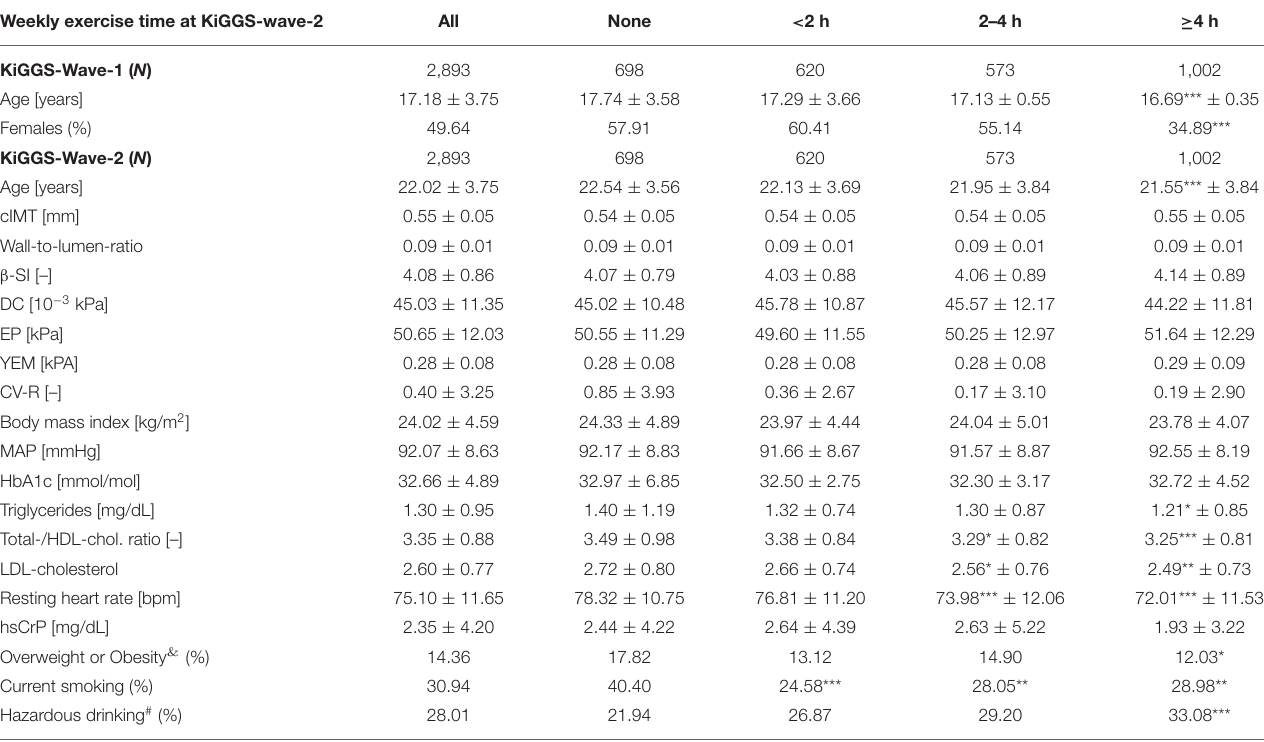
TABLE 1 | Characteristics of the study sample. Weekly exercise time at KiGGS-wave-2